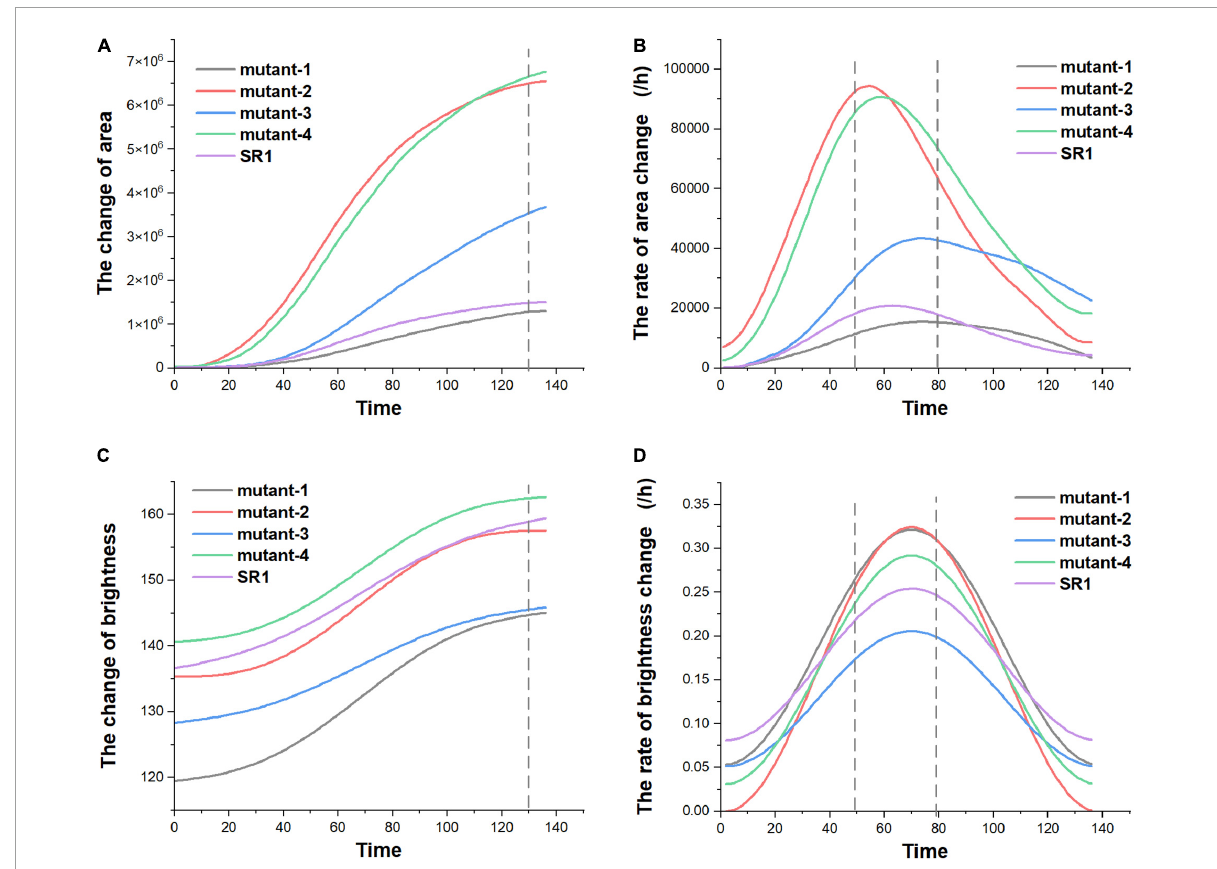
FIGURE9 The green fluorescence area and brightness change over time of SR1 and 4 mutant lines plants. Panel (A) showed the change of green fluorescence area, panel (B) showed the rate of green fluorescence area change per hour, panel (C) showed the change of green fluorescence brightness, and panel (D) showed the rate of green fluorescence brightness change per